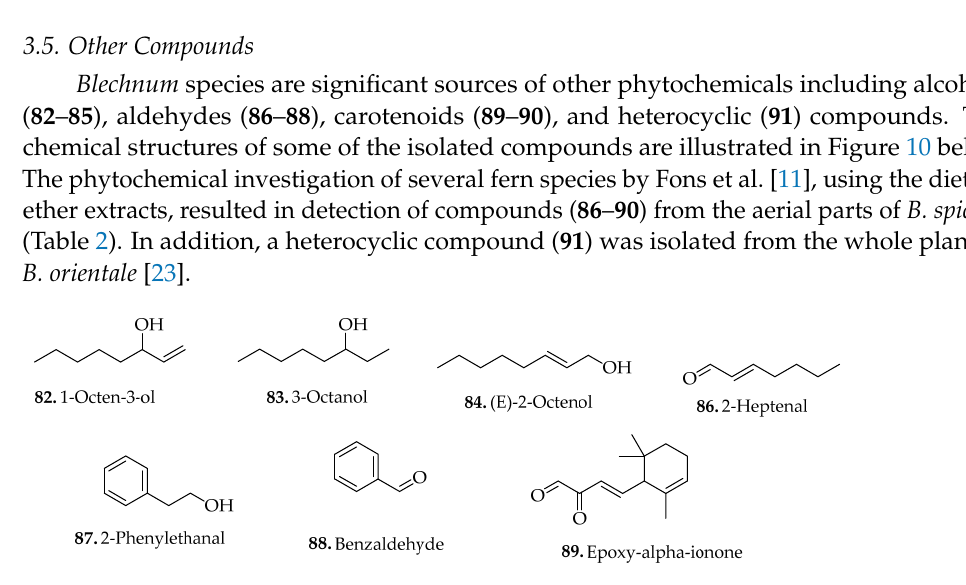
Figure 10. Chemical structures of alcohols, aldehydes and carotenoids from Blechnum species.